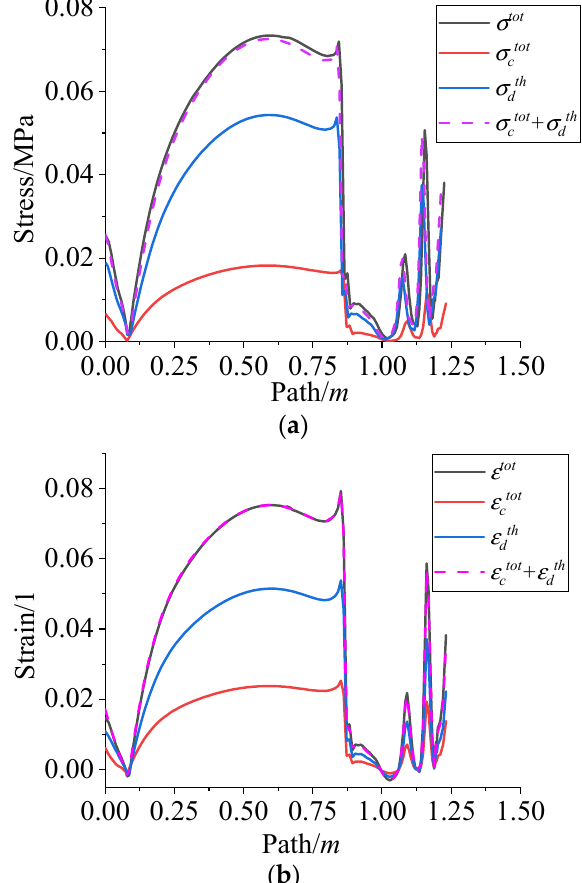
Figure 15. ( a ) Residual stress components vary along path 1. ( b ) Residual strain components vary along the path 1. Table 3. The proportion of residual stress and strain